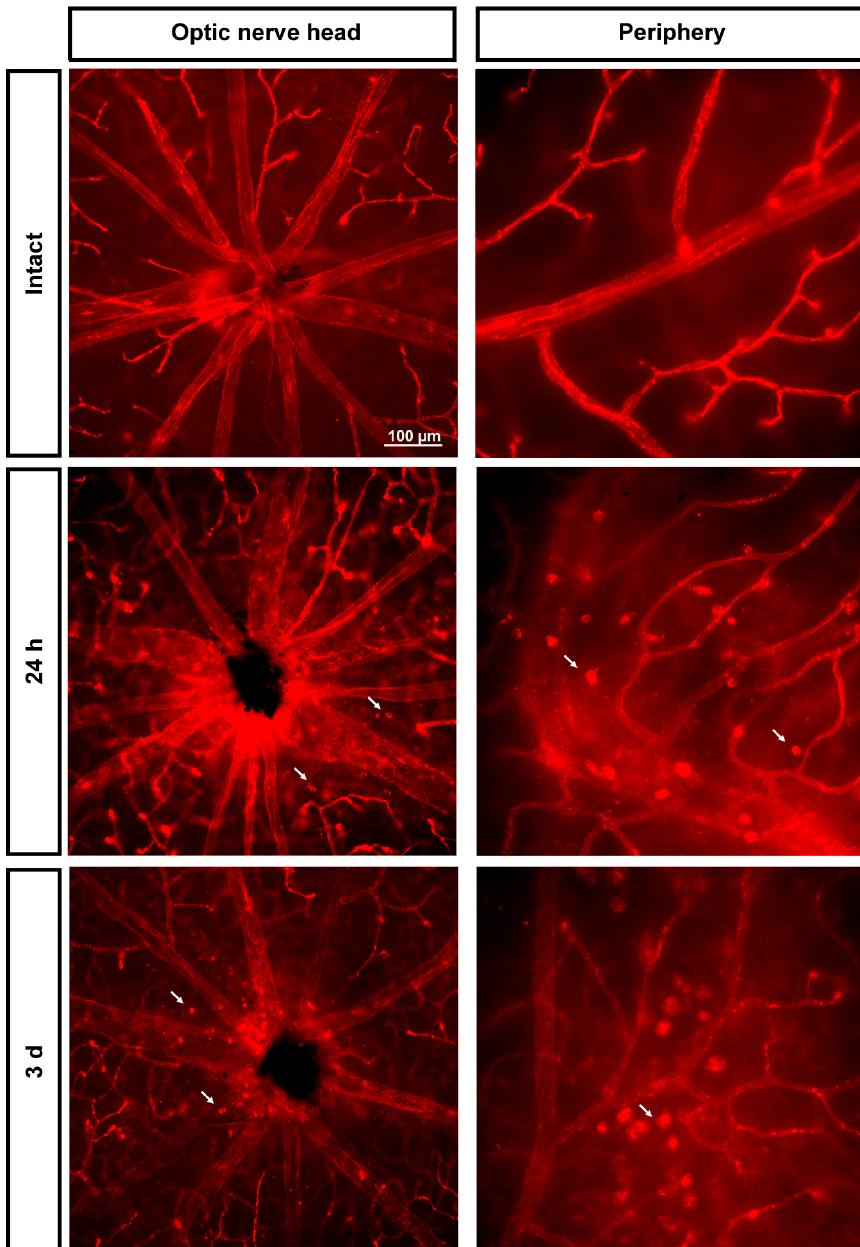
Figure 5. Extravasation of classically activated monocyte/macrophages early after the induction of transient ischemia. Ly6c expression in the superficial plexus around the optic nerve head and in the periphery of intact retinas and retinas analyzed 24 h and 3 days after the ischemia. Arrows point to extravasated classically activated monocytes/macrophages.